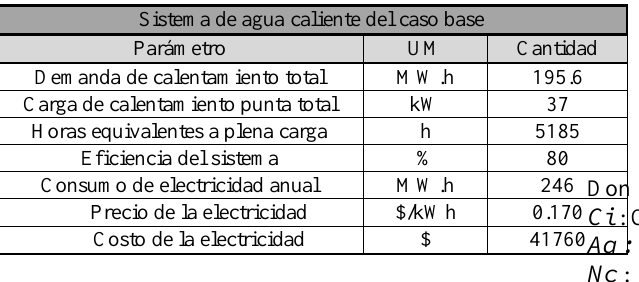
Tabla 1: Resumen del sistema de ACS para el caso base.